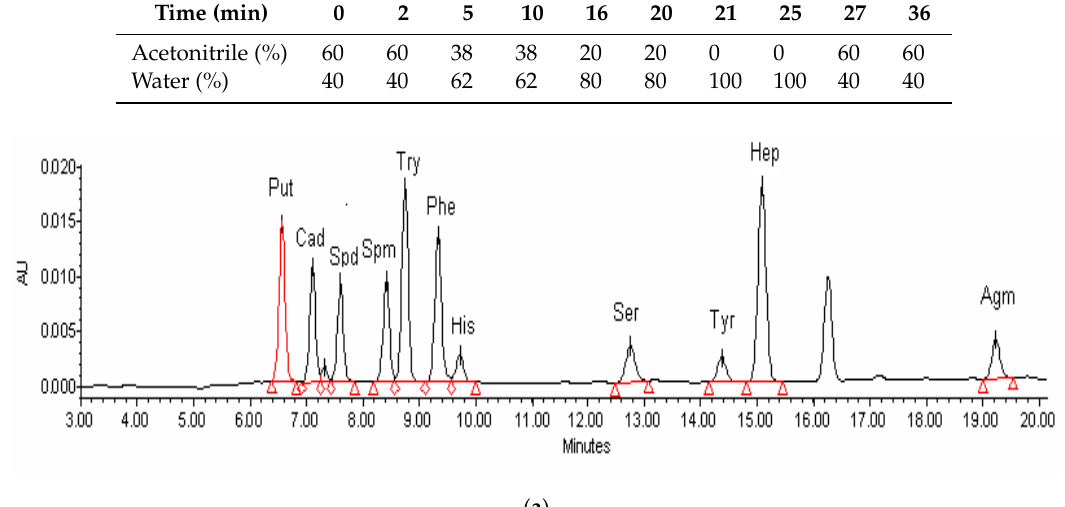
Table 1. Gradient elution program for biogenic amines analysis.